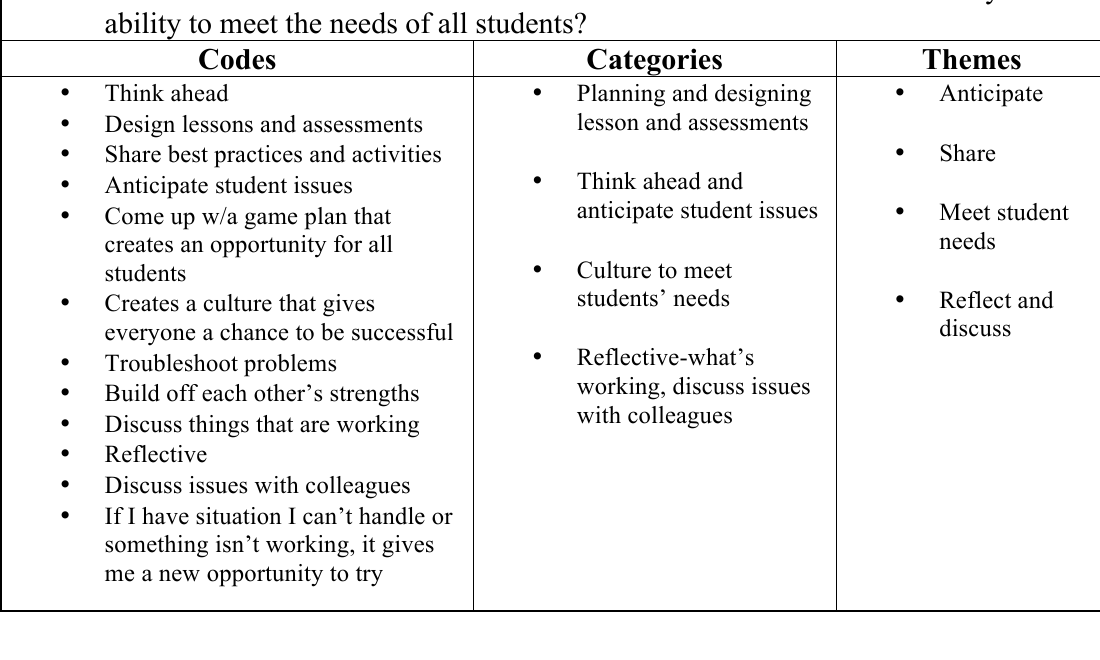
Teacher Question Five and